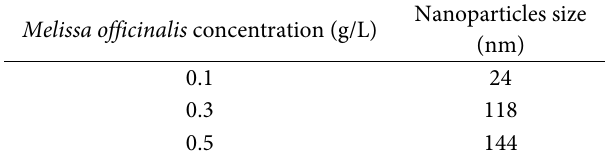
Table 2. Effect of the extract concentrations on the nanoparticle size.